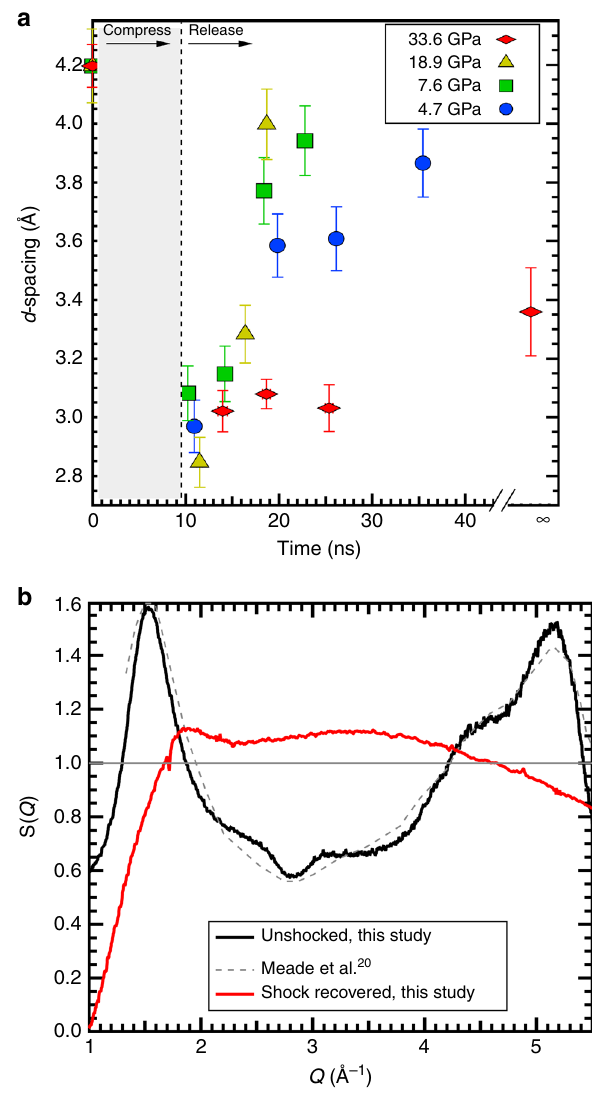
Fig. 3 Time-dependence and S( Q ) for fi rst sharp diffraction peak. a For each trace, corresponding to a time delay within a given pressure data set, the peak center of the fi rst sharp diffraction peak d -spacing is measured from the raw data, where the error bar indicates one standard deviation for the Gaussian pro fi le fi t. The trend for the lowest three pressures appears to return to a d -spacing similar to the original fused silica starting material.